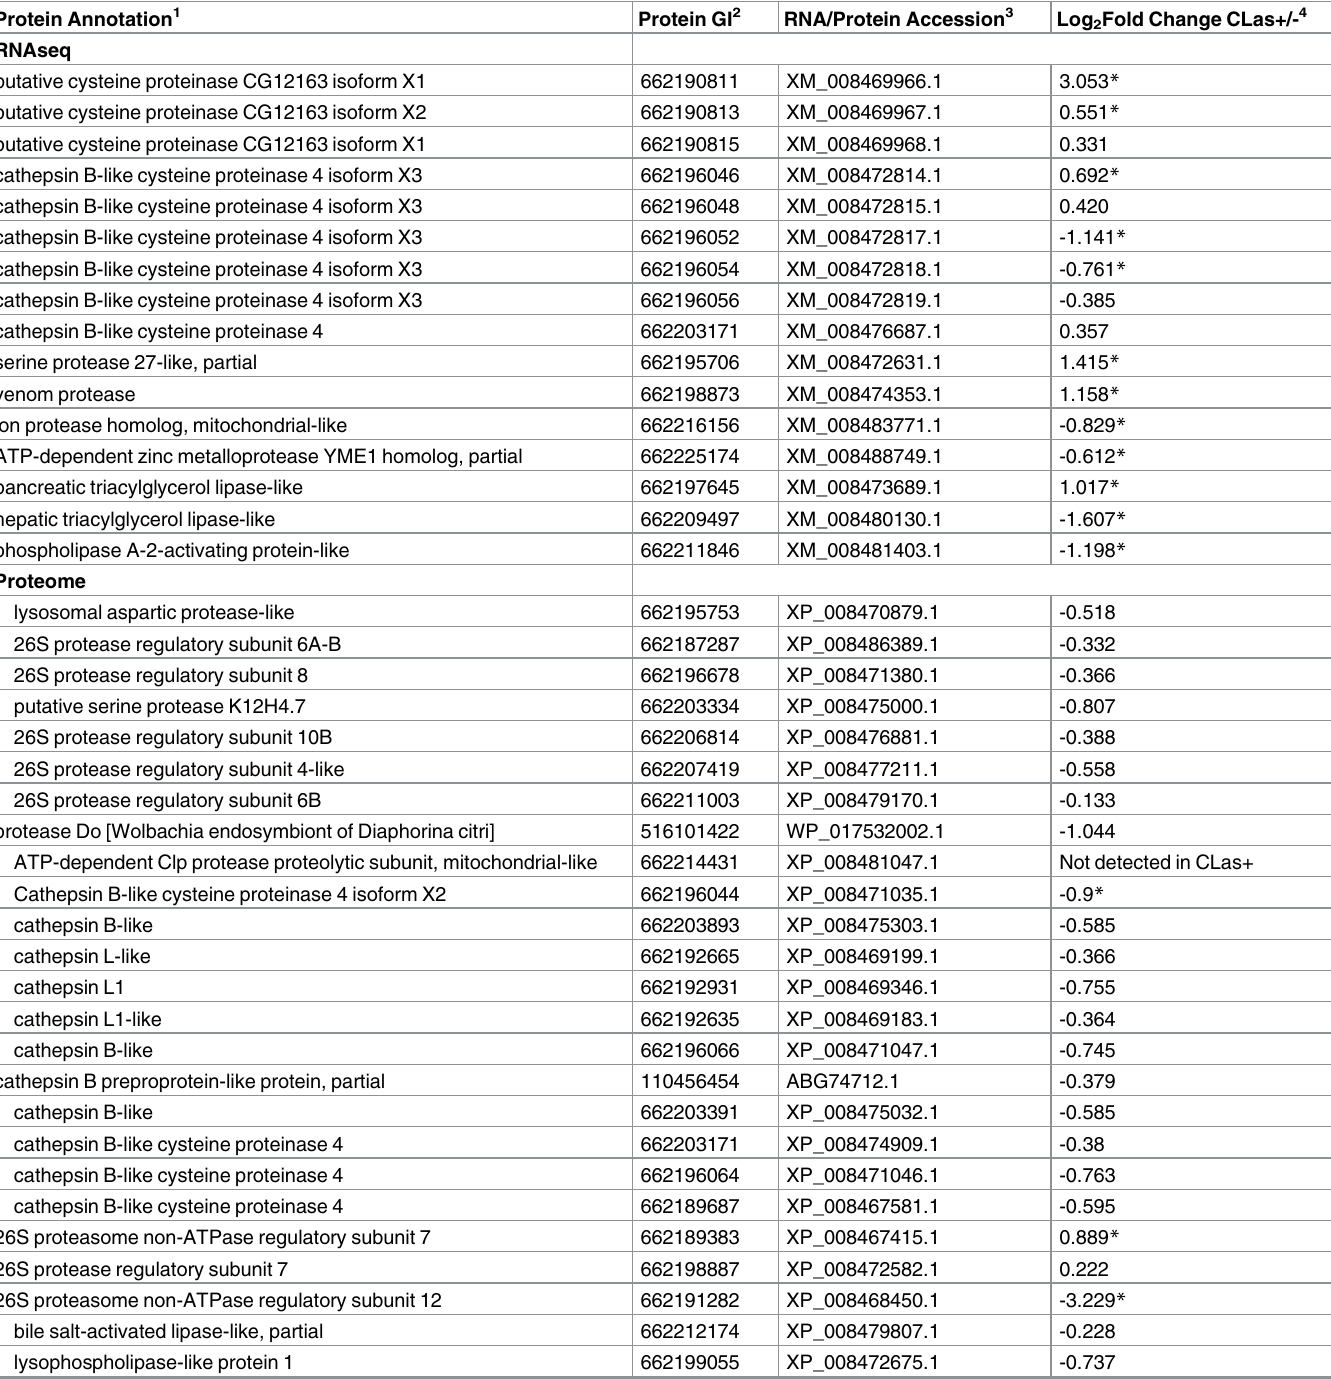
Table 4. Digestive proteins and transcripts detected in the ACP gut. Proteins annotated as proteasesor lipasesare includedhere from both the RNAseq and proteomedataset. Protein Annotation